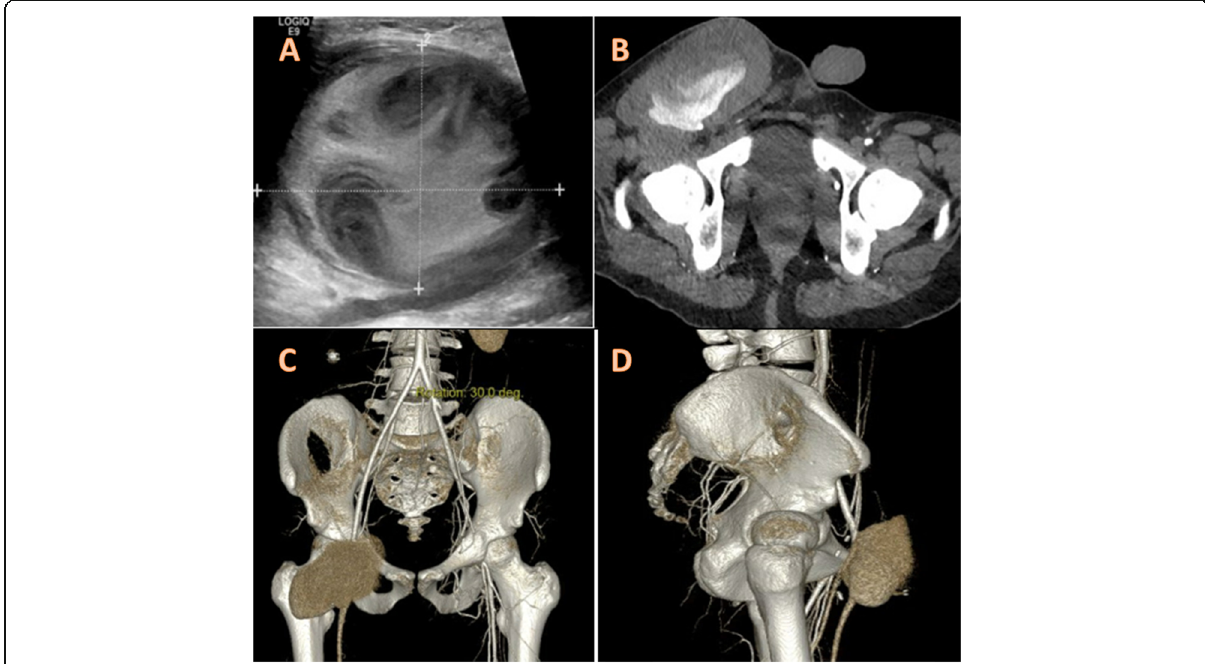
Fig. 1 A 21-year-old male patient developed acute right groin swelling after right femoral ECMO decannulation. Groin US revealed a large swelling (7 × 5 cm) with heterogenous echogenicity in the right groin area arising from right femoral artery with the neck measuring 0.6 cm ( a ). CT angiography revealed the large pseudo-aneurysm (12 × 6 cm) from the right common femoral artery with active contrast extravasation ( b ). Multiplanar reconstruction and advanced 3-D postprocessing were performed and revealed the large pseudo-aneurysm with good distal arterial flow ( c , d ). Vascular surgery was done with evacuation of the pseudo-aneurysm and repair of the femoral artery